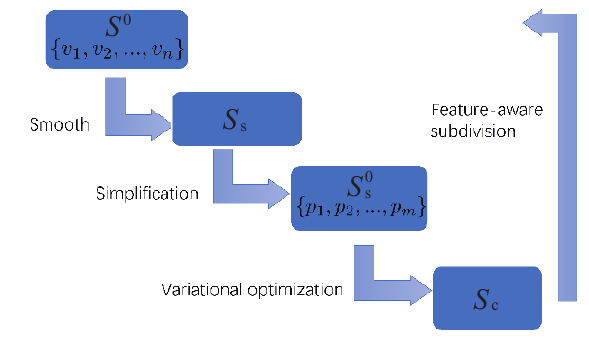
Fig. 4 Pipeline of our approach.